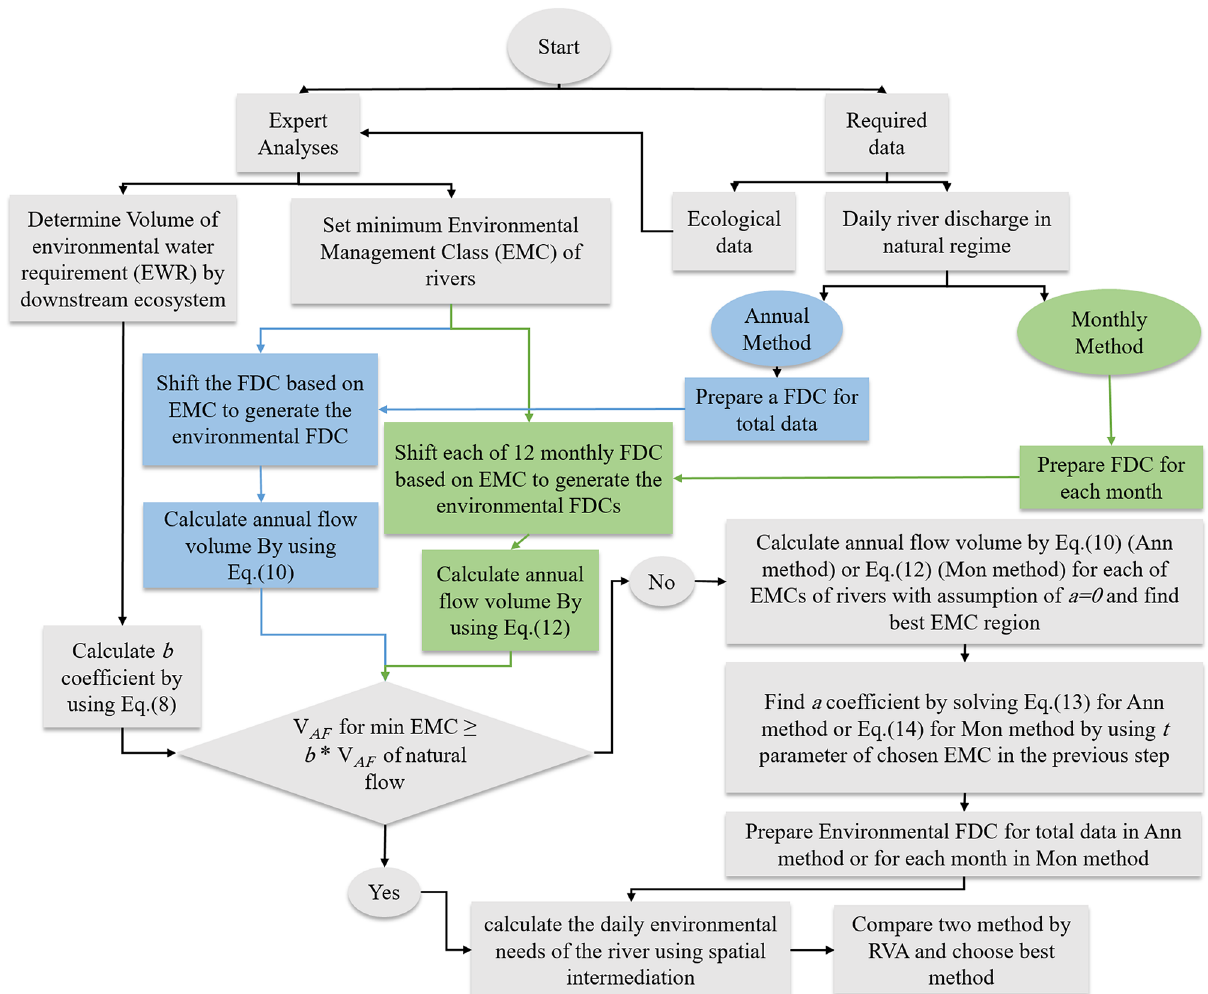
Figure 4. Step-by-step flowchart for determining the environmental flows of rivers in the Urmia Lake